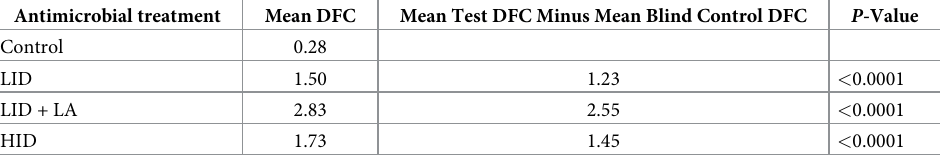
Table 4. Effect of interventions (LDI, LDI combined with LA and HDI) on mean panel data and P -value of the dif- ference from control (DFC) test of beef burgers. Antimicrobial